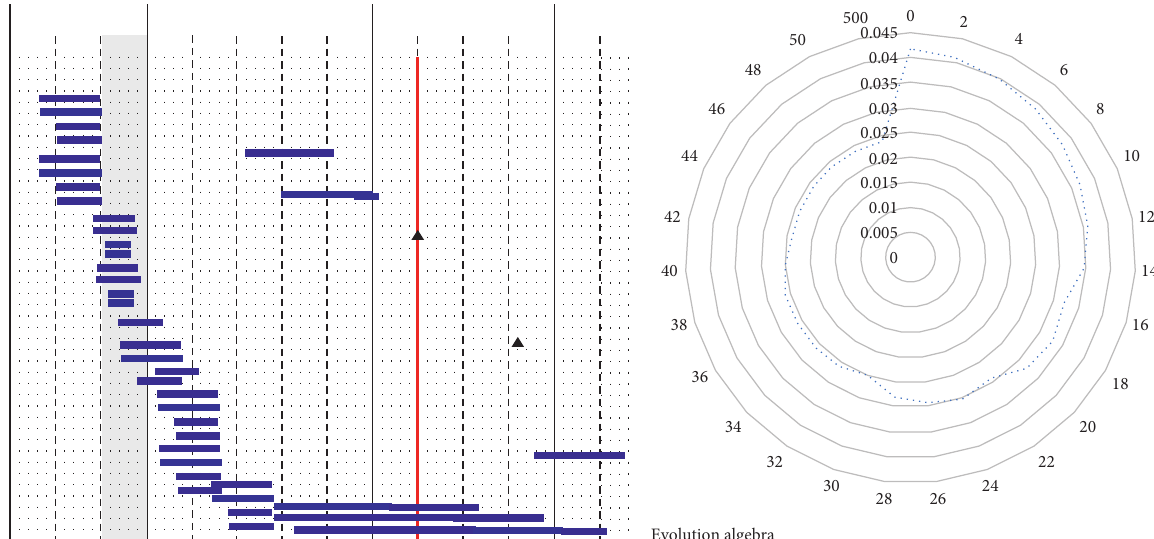
Figure 9: Genetic algorithm convergence result stability evaluation of rock slope.